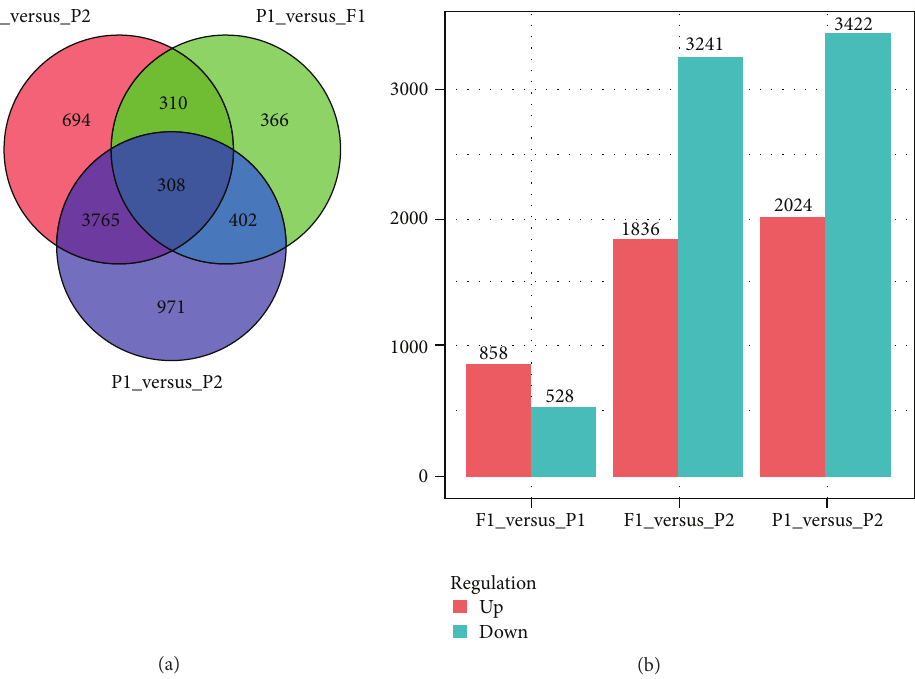
Figure 5: Total numbers of differentially expressed genes between P1, P2, and F1 by Venn diagram analyses (a) and statistics of up- or downregulated genes